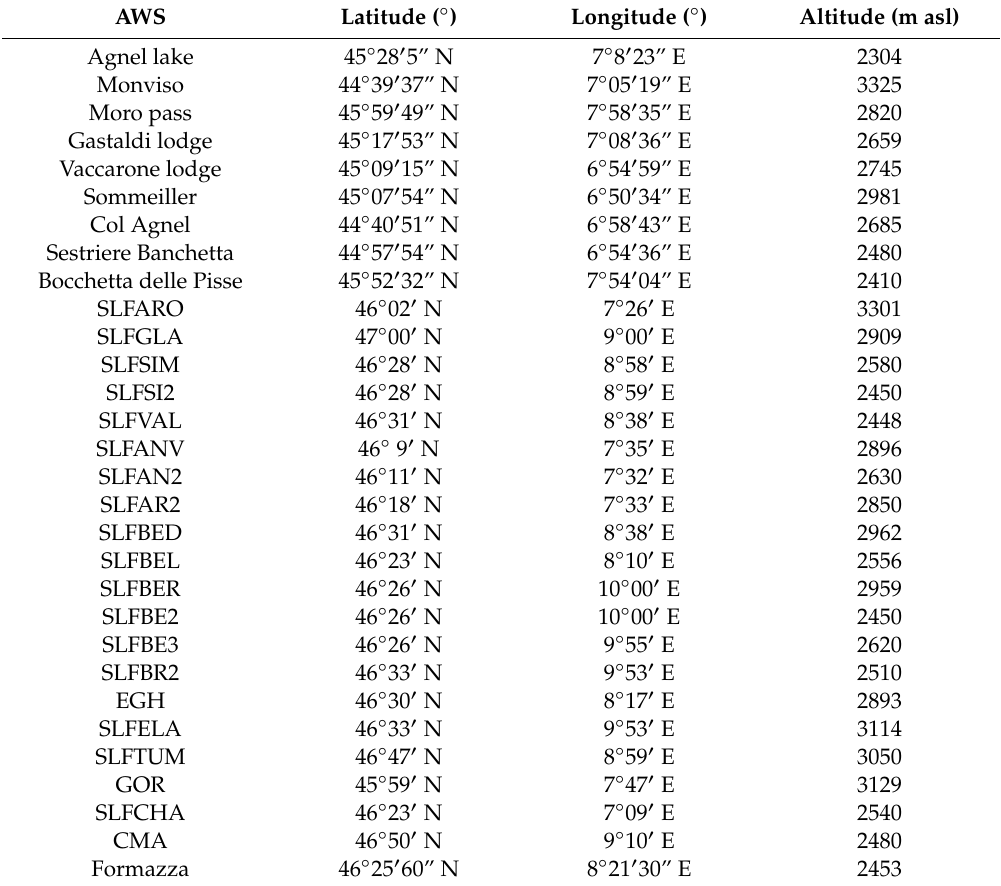
Table 2. AWS stations used for temperature lapse rate